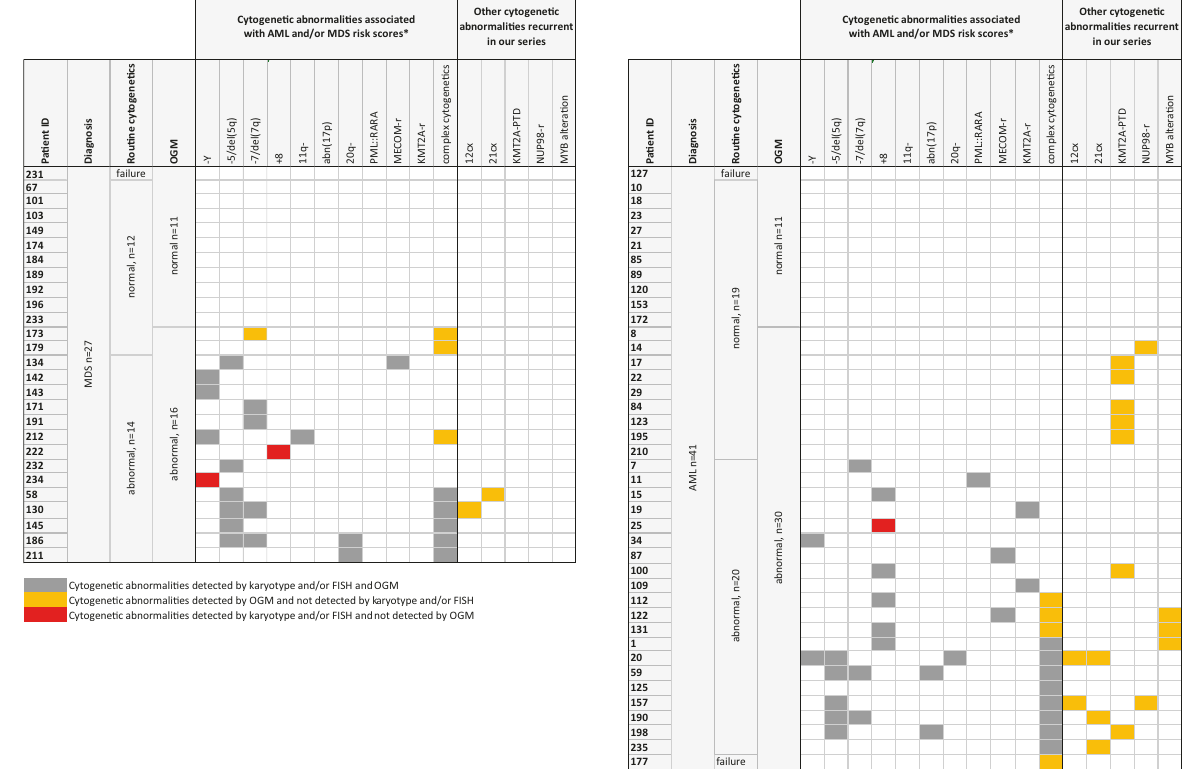
Fig. 1 Summary of cytogenetic abnormalities detected in AML (left panel) and MDS (right panel) cases according to the cytogenetic method (karyotype/FISH versus OGM). Cytogenetic results reported here include the cytogenetic abnormalities associated with AML and/or MDS risk scores and the other cytogenetic abnormalities recurrent in our series. Concordant results as well as abnormalities only detected by one of the technique are indicated. *detected categories only; cx complex rearrangement; r (Fig. S9). Ampli fi cation of the ERG gene was observed in all these cases and was associated with an ampli fi cation of the RUNX1 gene in 3/4 cases. Until now, this abnormality has probably been considered as an intrachromosomal ampli fi cation of chromosome 21 and underestimated in AML [11]. Overall, OGM detected additional relevant cytogenetic abnorm- alities in 17% (2/12) of MDS cases and 47% (9/19) of AML cases with normal routine cytogenetics, and in 22.2% (2/9) of MDS cases and 50% (6/12) of AML cases with simple abnormal routine cytogenetics (Table S2). In all cases with complex karyotypes (5 MDS and 8 AML cases) except UPN 125 with hyperdiploidy, OGM revealed an even more complex karyotype (Table S2). In AML cases, we identi fi ed three recurring classes of abnormalities ( i.e . observed in at least two patients) namely partial tandem duplication of the KMT2A gene ( KMT2A -PTD) (7/41 AML cases), alteration of the MYB gene (3/41 AML cases) and rearrangement of the NUP98 gene (2/41 AML cases) (Fig. 1). In all cases, KTM2A -PTD was detected by OGM as an insertion in the KMT2A gene given the small size of the duplication (Fig. 2D and Fig. S10). KMT2A -PTD has been recently reported to be associated with an adverse prognosis in MDS patients in the novel molecular IPSS risk score, showing its importance [12]. Interestingly, NUP98 rearrangements led to the formation of the NUP98::NSD1 fusion gene in UPN 14 (Fig. 2E) and NUP98::TNRC18 fusion gene in UPN 157 (Fig. S11). NUP98 rearrangements are routinely investigated in childhood AML but to date, not in adult AML [13]. Alteration of the MYB gene consisted of duplication in UPN 122 (Fig. S12A, B), a translocation t(6;15) in UPN 1 (Fig. 2F, G) and an insertion ins(6;7) in UPN 131 (Fig. S12C, D). MYB overexpression has been described in AML, ALL, and lymphomas, and recurrent translocations and